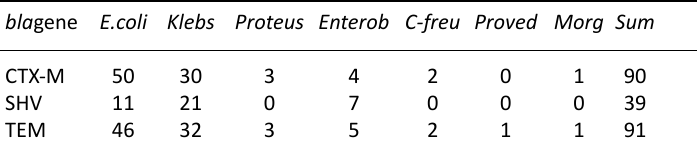
Table 4. Sequencing results for bla SHV-positive isolates SHV- Total No.